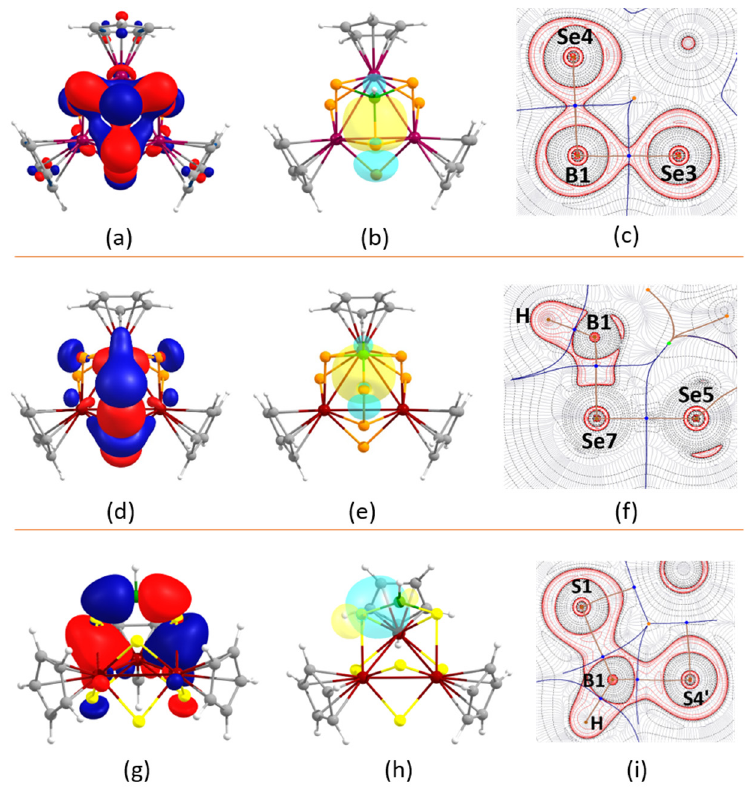
Figure 4. Investigation of the B-Se, Se-Se, and B-S bonding of 1 , 2 , and 3 , respectively. ( a ) HOMO-6 of 1 , ( b ) NBO depicting the B-Se bonding interaction in 1 , ( c ) contour-line diagrams of the Laplacian of electron density in the Se3-B1-Se4 plane of 1 , ( d ) HOMO-26 of 2 , ( e ) NBO depicting the B-Se bonding interaction in 2 , ( f ) contour-line diagrams of the Laplacian of electron density in the B1-Se7-Se5 plane of 2 , ( g ) HOMO-23 of 3 , ( h ) NBO depicting the B-S bonding interaction in 3 , ( i ) contour-line diagrams of the Laplacian of electron density in the S1-B1-S4 ′ plane of 3 . In the contour-line diagrams of the Laplacian of electron density, solid red lines indicate areas of charge concentration [ ∇ 2 ρ (r) < 0], while dashed black lines show areas of charge depletion [ ∇ 2 ρ (r) > 0]. Blue dots indicate bond critical points (BCPs), and the brown line depicts the bond paths. (Contour values for isosurface = ±0.04 [e/bohr 3 ] 1/2 ).